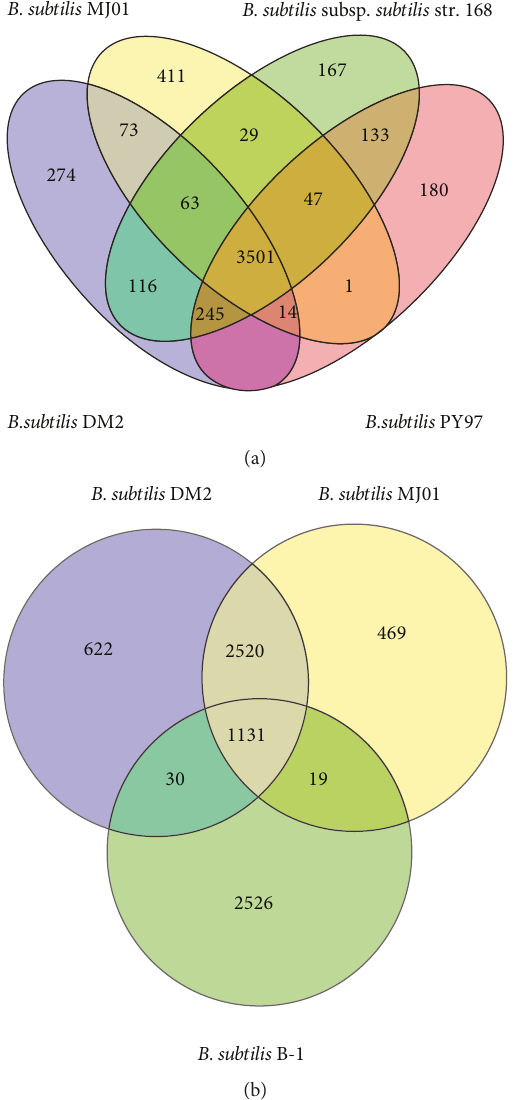
Figure 5: Comparative analysis of protein sets among four B. subtilis strains selected. (a) Orthologous set of proteins in B. subtilis DM2, B. subtilis subsp . subtilis str. 168, B. subtilis PY79, and B. subtilis MJ01. (b) Orthologous set of proteins in B. subtilis DM2, B. subtilis MJ01, and B. subtilis B-1.